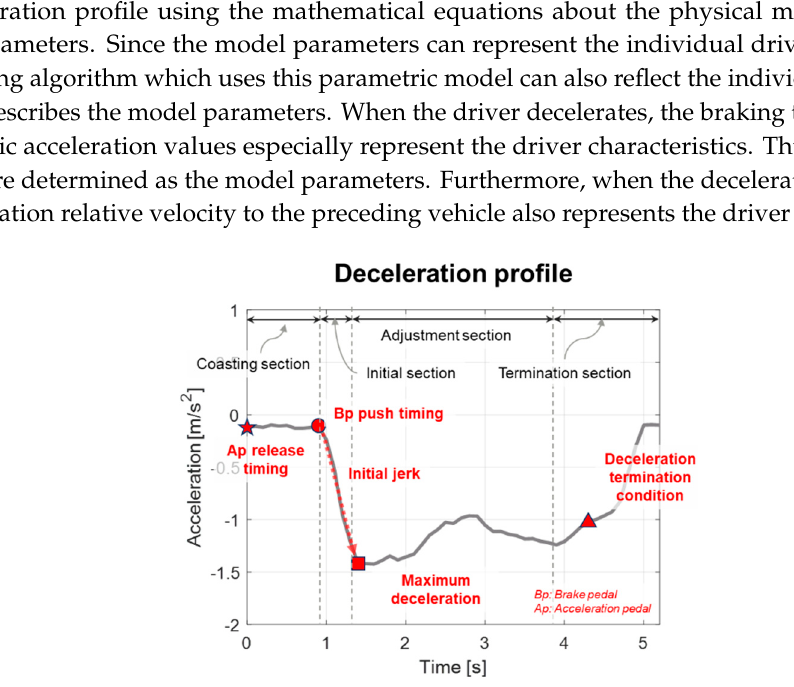
Figure 6. Driver model parameters and deceleration profile.